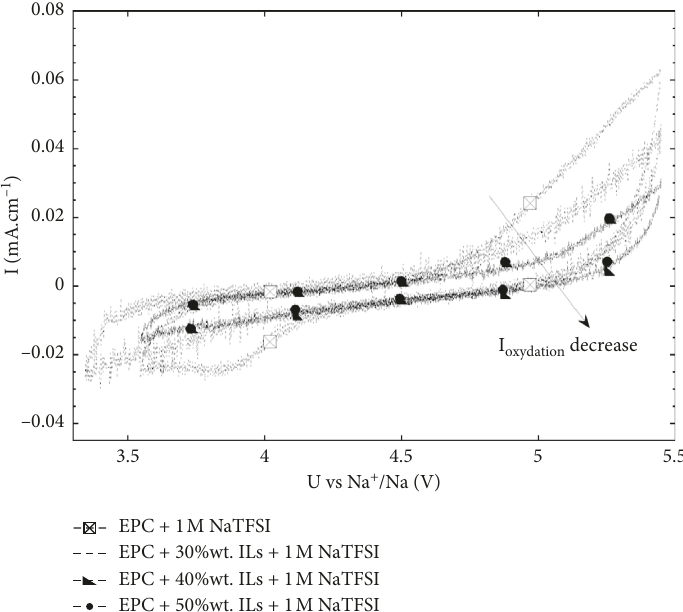
Figure 4: Cyclic voltammetry profiles of EMI-TFSI used as co-solvent with binary system EC-PC and 1M NaTFSI